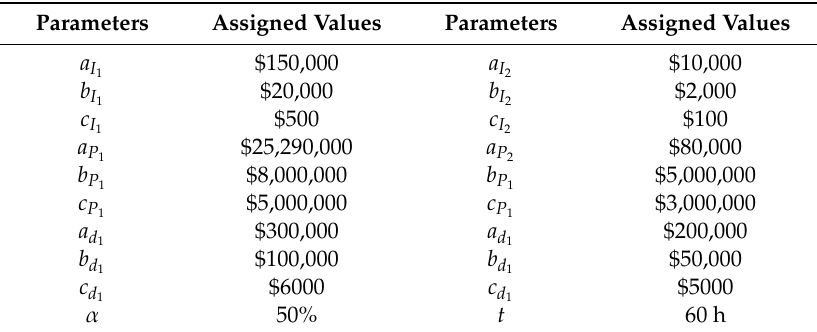
Table 2. Basic assumption of the